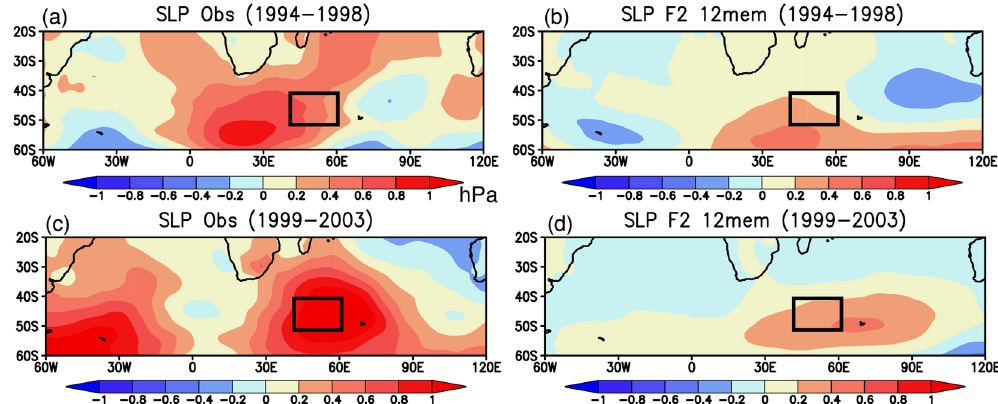
Figure 4. ( a , c ) 5-yr mean SLP anomalies (in hPa) observed during 1994–1998 and 1999–2003, respectively. The black boxes indicate the region where the SWIO index was calculated. ( b , d ) Same as in ( a , c ), but for the reforecast experiments initialized from March 1st 1994. Here we show 12 ensemble mean SLP anomalies. The maps were generated using Grid Analysis and Display System (GrADS) Version 2.1.a3 (http://cola.gmu.edu/ grads/downloads.php).